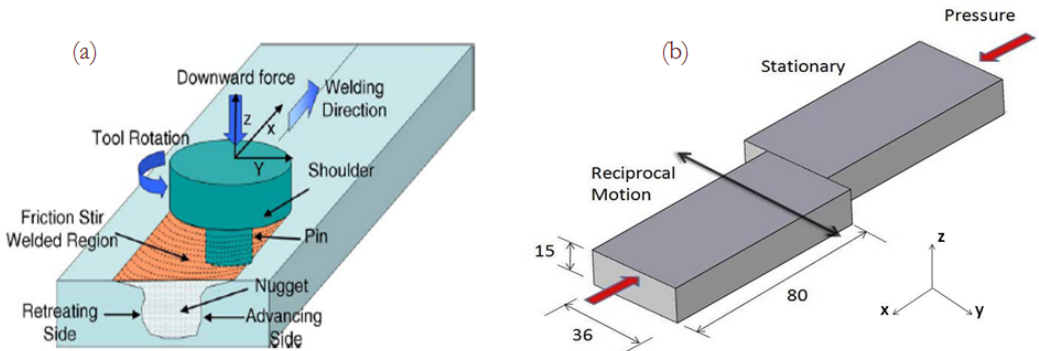
Figura 1: Rappresentazione schematica dei processi (a) FSW [7] e (b) LFW